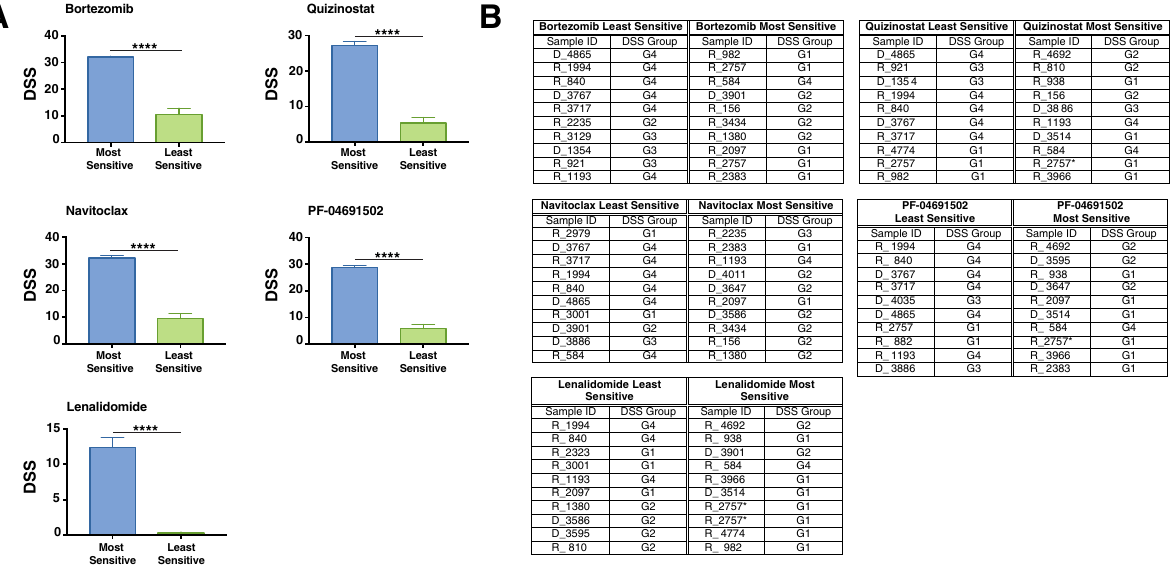
Figure 1. Patients show differential response to five different classes of drugs. ( a ) Most and Least Sensitive patients have a significantly different DSS (p < 0.001) across six drug treatments. ( b ) DSS group of most sensitive and least sensitive patients to six drugs. The least sensitive group was comprised of Group 4 patients whereas the most sensitive group was comprised of patients ranging from Group 1 to Group 3. *The 2nd sample from the patient with longitudinal